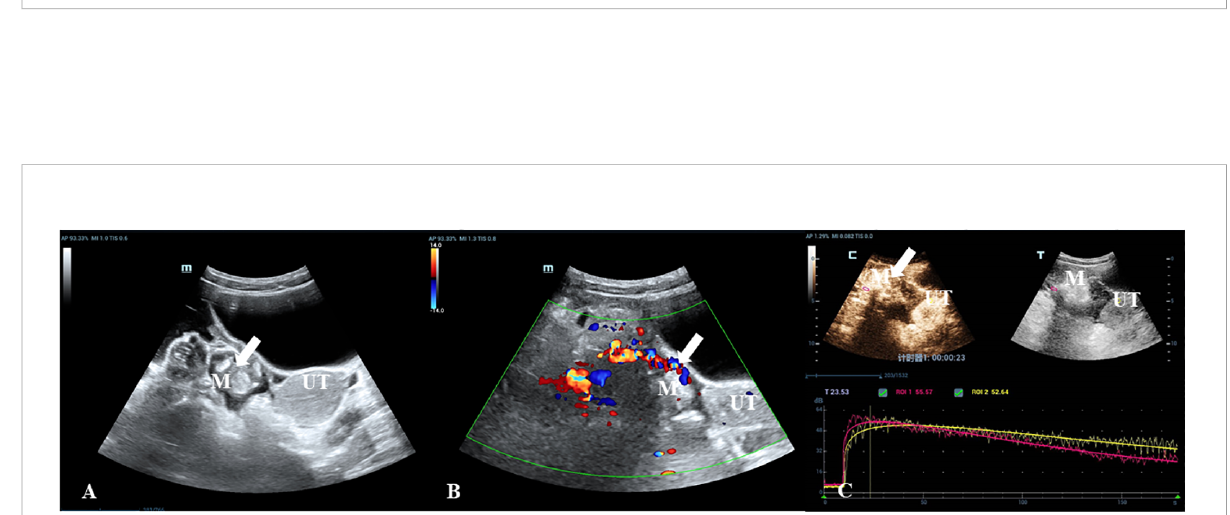
FIGURE 3 A 35-year-old woman with a pathologically proven immature teratoma. (A) Transabdominal gray-scale ultrasound shows a 30-mm complex cystic-solid mass (M) in the right adnexa. (B) Color Doppler reveals the color fl ow within the mass (color score=4). (C) CEU curve demonstrates that the tumor showed hyperenhancement in initial perfusion and faster washout compared with myometrium (mass: red, myometrium: